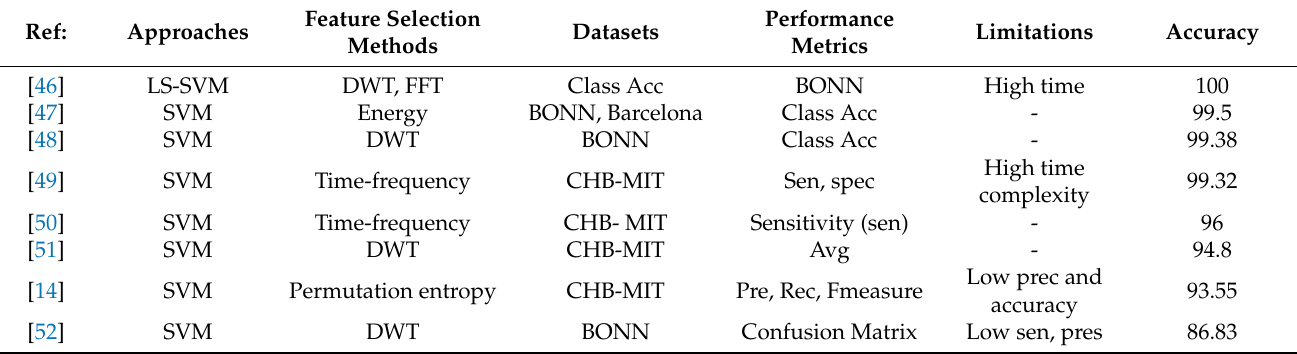
Table 6. A review on SVM approach for seizure detection.